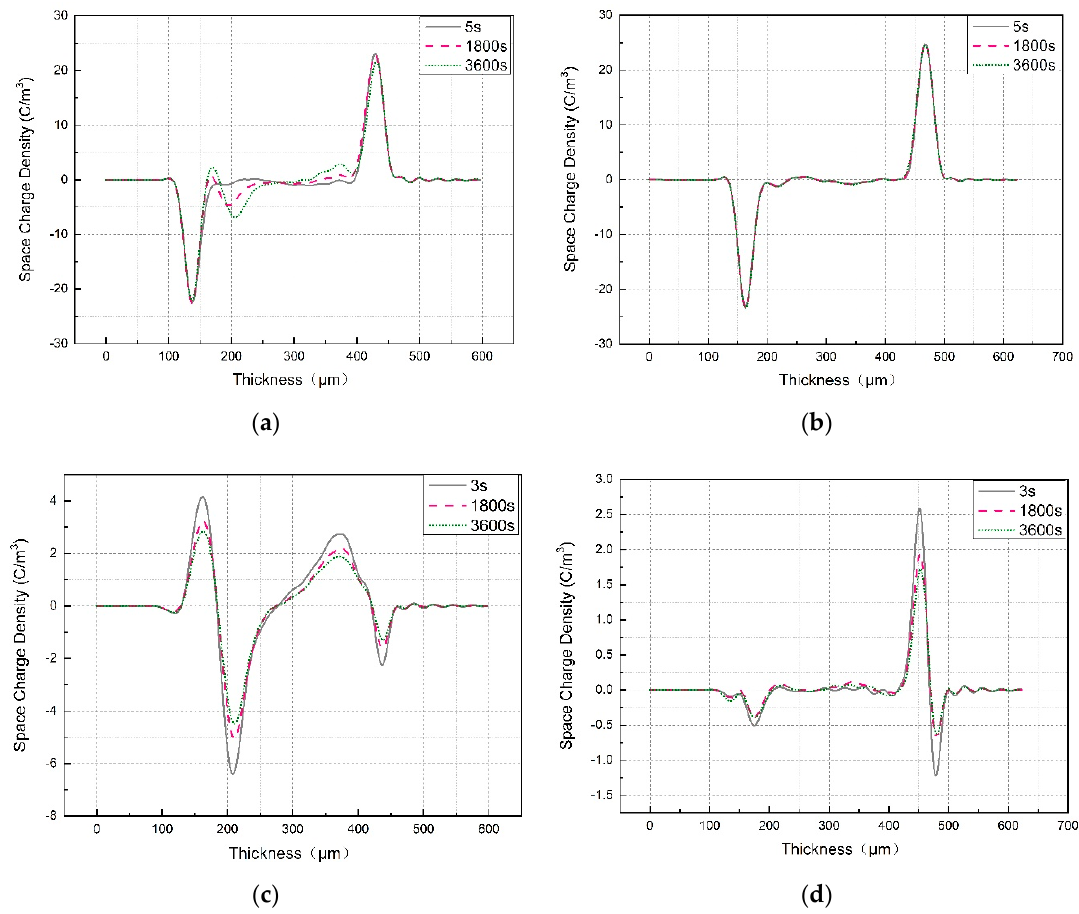
Figure 7. Space charge distribution of LDPE and LDPE-g-PS/LDPE blend ( a ) under applied voltage for LDPE, ( b ) under applied voltage for LDPE/LDPE-g-PS, ( c ) short circuit of LDPE, and ( d ) short circuit of LDPE/LDPE-g-PS.